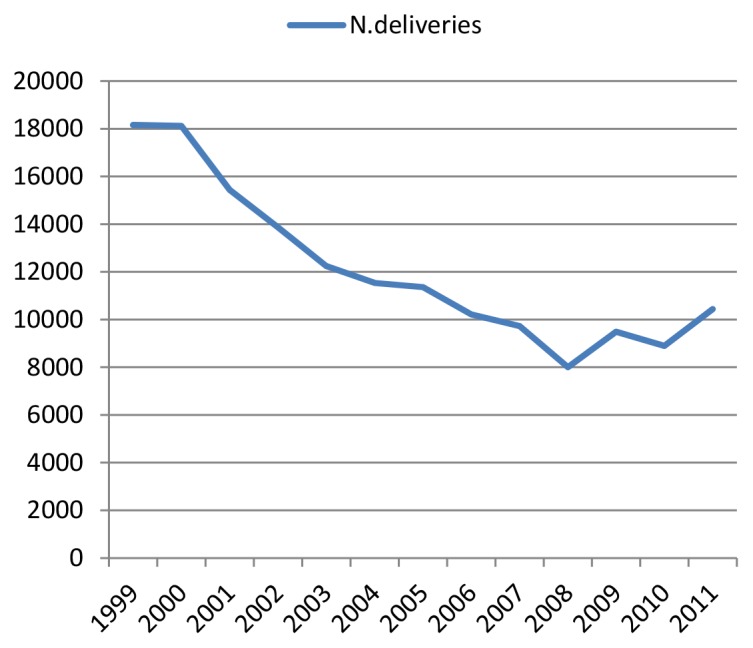
Trend of annual deliveries at MNH.